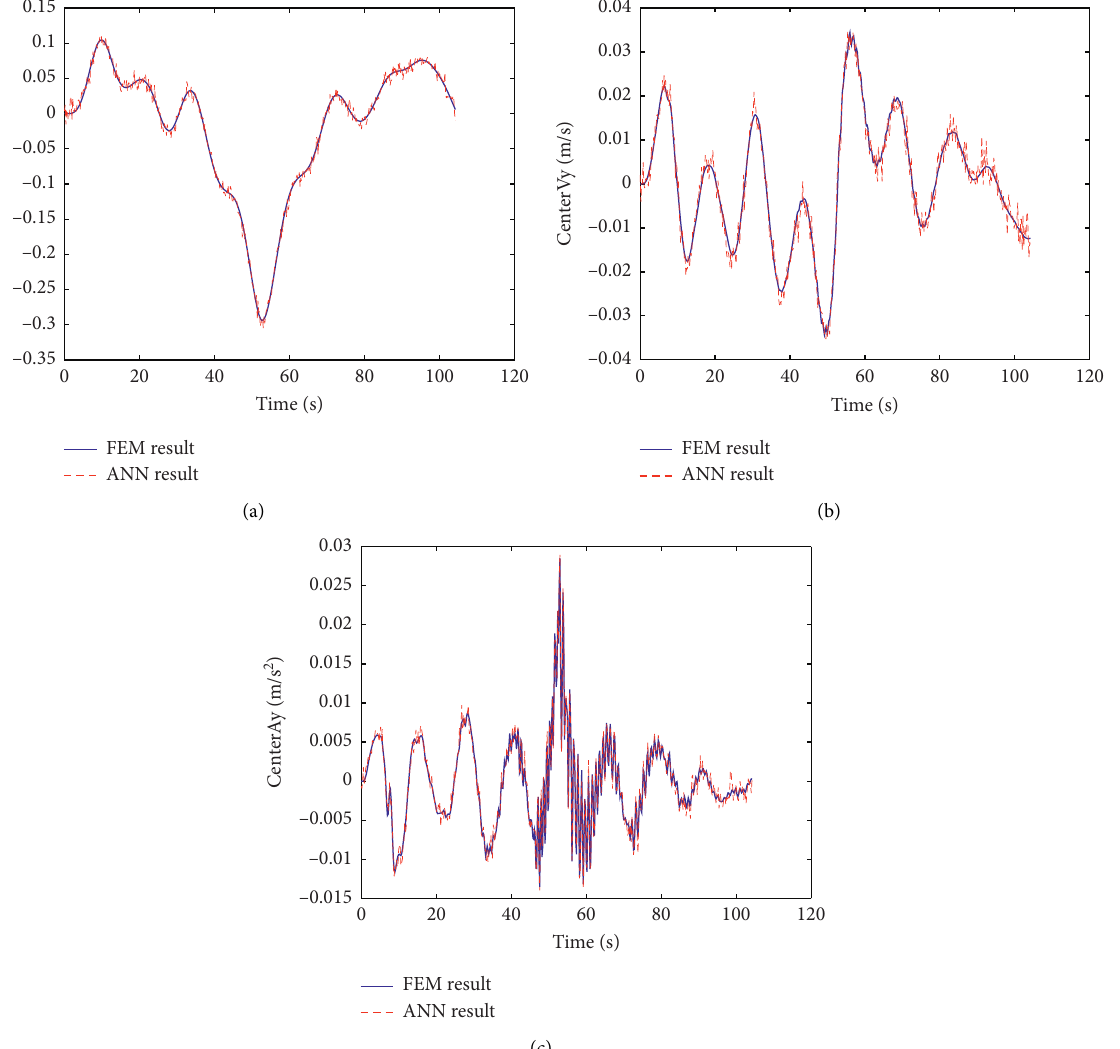
Figure 10: Comparison between BP neural network time-history results and finite element time-history results: (a) comparison of time- history results of vertical displacement in the middle of the span for dynamic coupling analysis of vehicle-bridge system; (b) comparison of time-history results of vertical speed in the middle of the span for dynamic coupling analysis of vehicle-bridge system; (c) comparison of time-history results of vertical acceleration in the middle of the span for dynamic coupling analysis of the vehicle-bridge